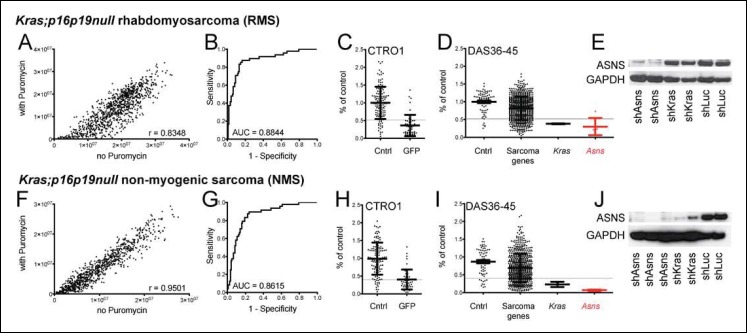
Functional genomic screening identified asparagine synthetase (ASNS) as a high-priority sarcoma target.141 sarcoma-relevant genes were identified by prior transcriptional profiling of genetically engineered Kras;p16p19null mouse rhabdomyosarcomas (RMS) and non-myogenic sarcomas (NMS) (Hettmer et al., 2011). (A–D, F–I) The contributions of each of the 141 sarcoma-relevant genes to sarcoma cell proliferation were determined by customized shRNA screening. (B–D, G–I). The screen contained a control set, including cells exposed to shLUC, shRFP, shLACZ (cntrl; predicted to have no effect on cell proliferation) and cells exposed to shGFP (GFP; predicted to silence Kras (G12V)-IRES-GFP and reduce cell proliferation). (B,G) Receiver operator curve analysis using cntrl-shRNA-infected cells as negative and shGFP-infected cells as positive controls determined a false discovery rate of <30% for shRNAs associated with a reduction in proliferation to <52% of the average of cntrl-shRNA-infected RMS cells (grey line in panel C) and to <40% of cntrl-shRNA-infected NMS cells (grey line in panel H). (D, I) The shRNA screen included cells exposed to shLUC, shRFP, shLACZ (cntrl), shKRAS and shRNAs directed against each of the 141 candidate genes (5 shRNAs per gene). ShRNAs directed against the gene encoding Asparagine Synthetase (Asns) showed the strongest effect on NMS and RMS proliferation (p<0.0001, q<0.01, 4–5 of 5 shRNAs with FDR<30%). (E–J) Effective ASNS knockdown by the shRNAs used in the screen was confirmed by Western blot. See Supplementary files 1–4 for raw data from the shRNA screen, and Supplementary files 5–6 for scores for each of the 141 candidate genes. Significance levels were defined as follows: 1, 5 shRNAs with FDR<30%; 2, 4 shRNAs with FDR<30%; 3, 3 shRNAs with FDR<30%.